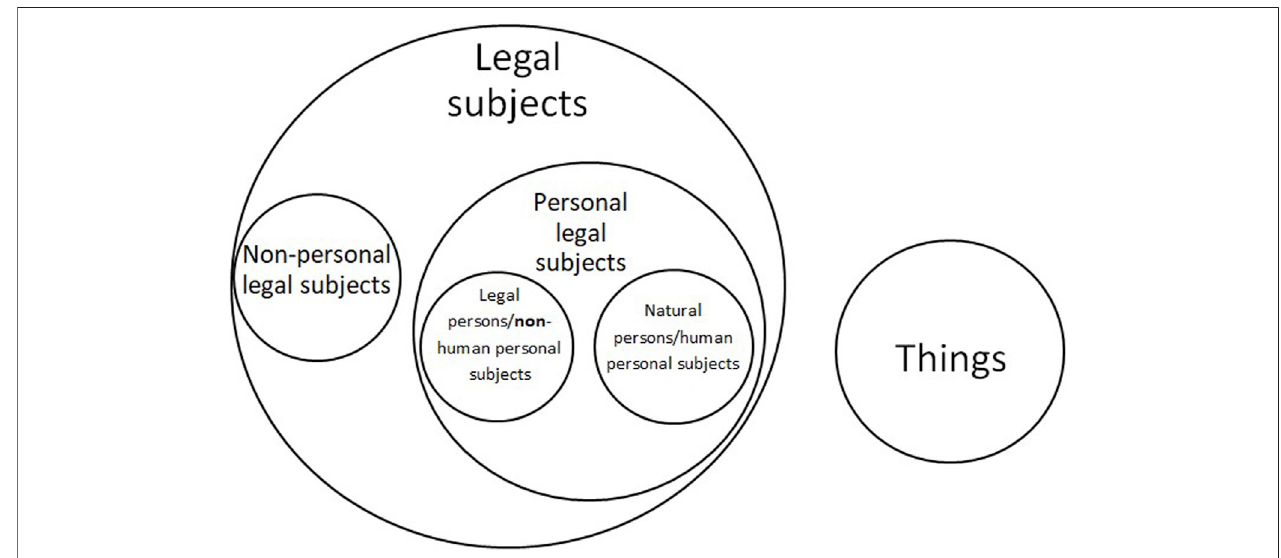
FIGURE 1 | Diversifying legal